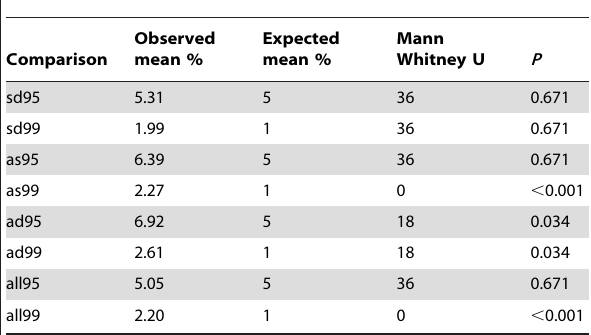
Table 3. Frequencies of outliers found in pair-wise comparisons of Hypoplectrus morphotype populations (i.e. individuals of a given morph at a given sampling location).